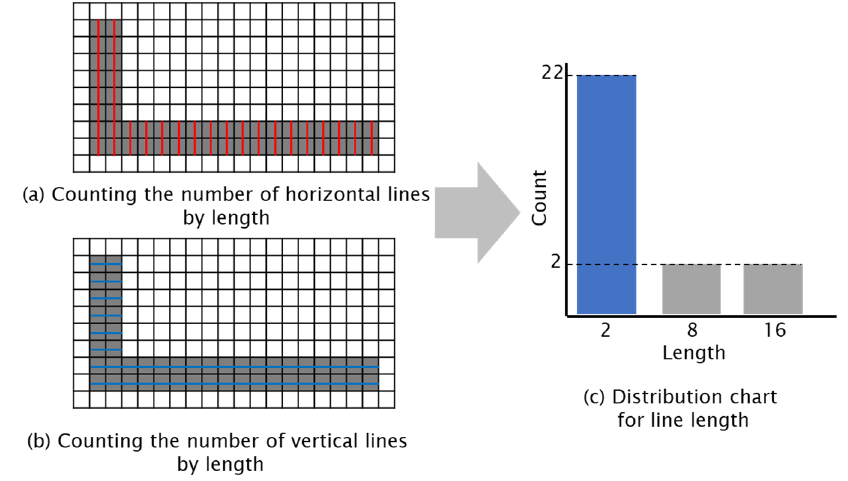
Figure 9. Generation of the distribution chart for line length.